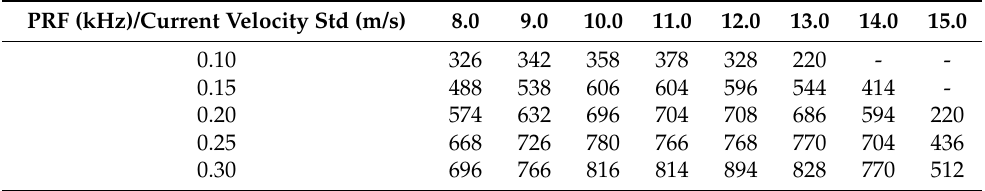
Table 3. Current field effective swaths of different current velocity Stds with different values of PRF.